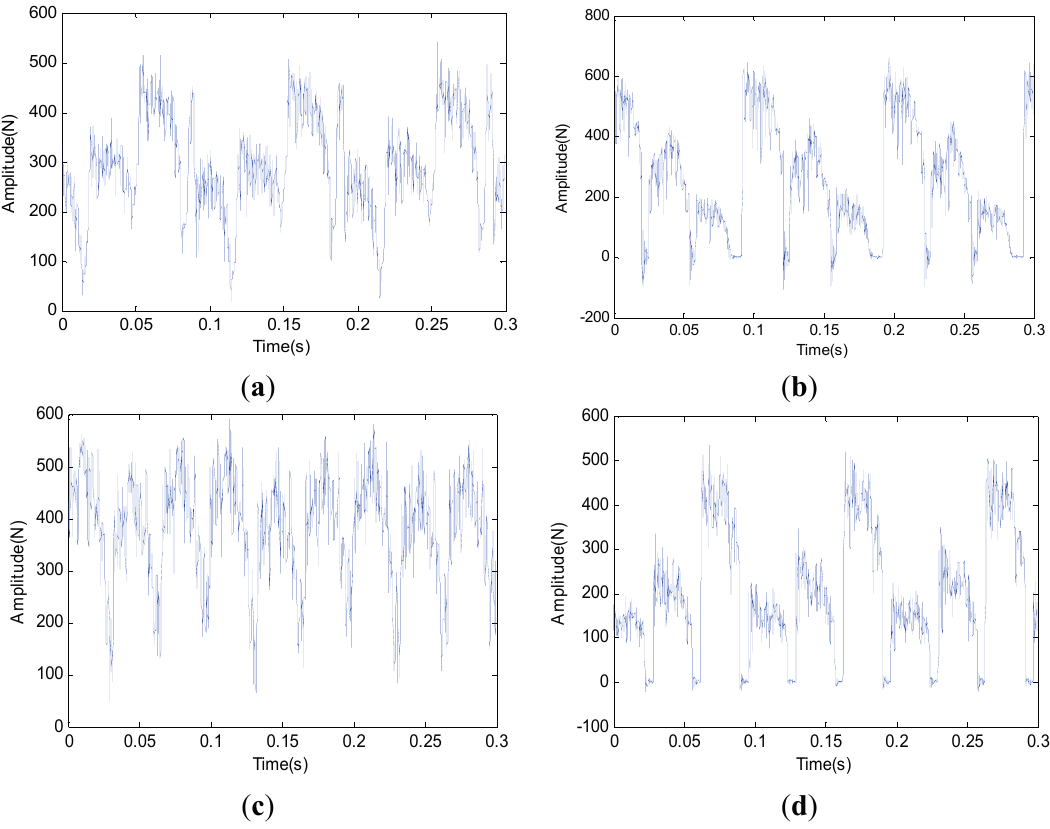
Figure 5. Force waveforms for different tool wear categories. ( a ) New tool; ( b ) Initial wear; ( c ) Middle wear; ( d ) Severe wear.